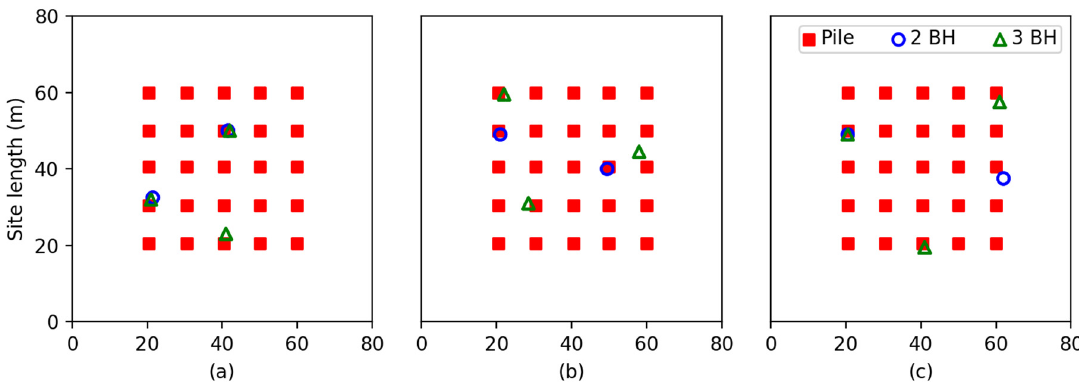
Figure 7. Comparison of borehole spacing for a 25-pile building with a soil SOF of ( a ) 10 m, ( b ) 15 m, and ( c ) 25 m.